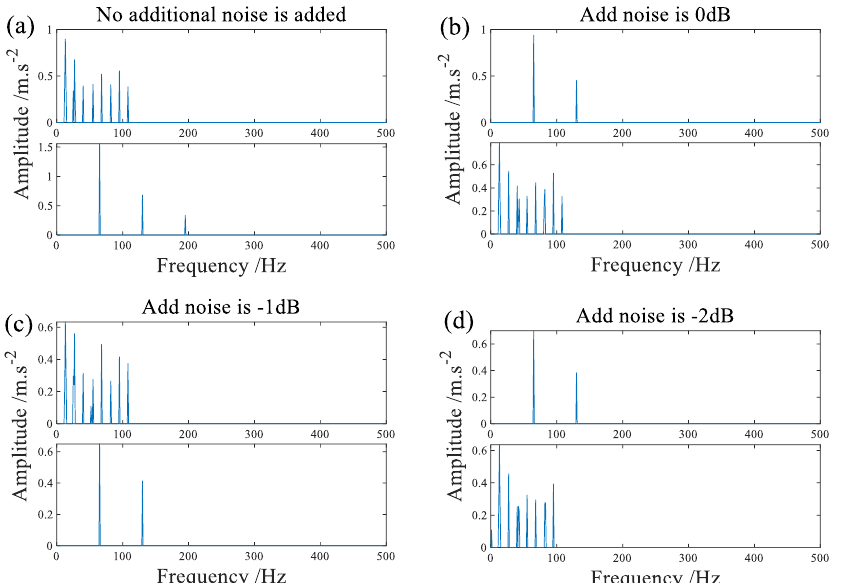
Figure 19. The signal is processed by SMF − DPC − OMP after additional noise, ( a ) is the case without adding noise, ( b – d ) is the case where 0 dB, − 1 dB, and − 2 dB of noise are added, respectively